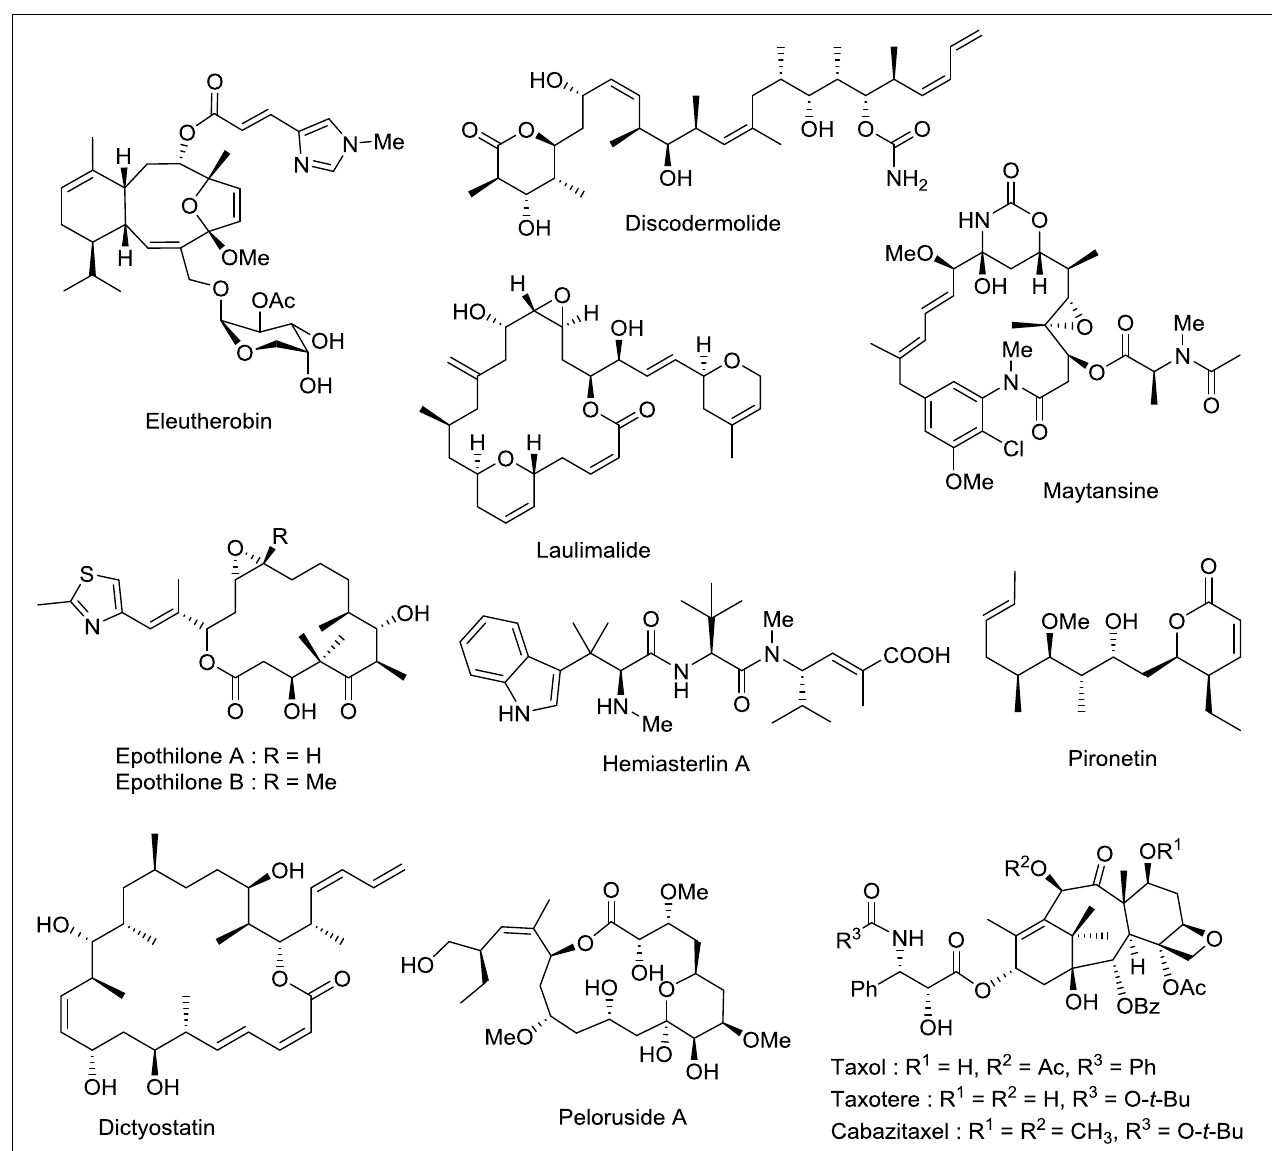
FIGURE 2 | Chemical structures of representative natural compounds that stabilize microtubule